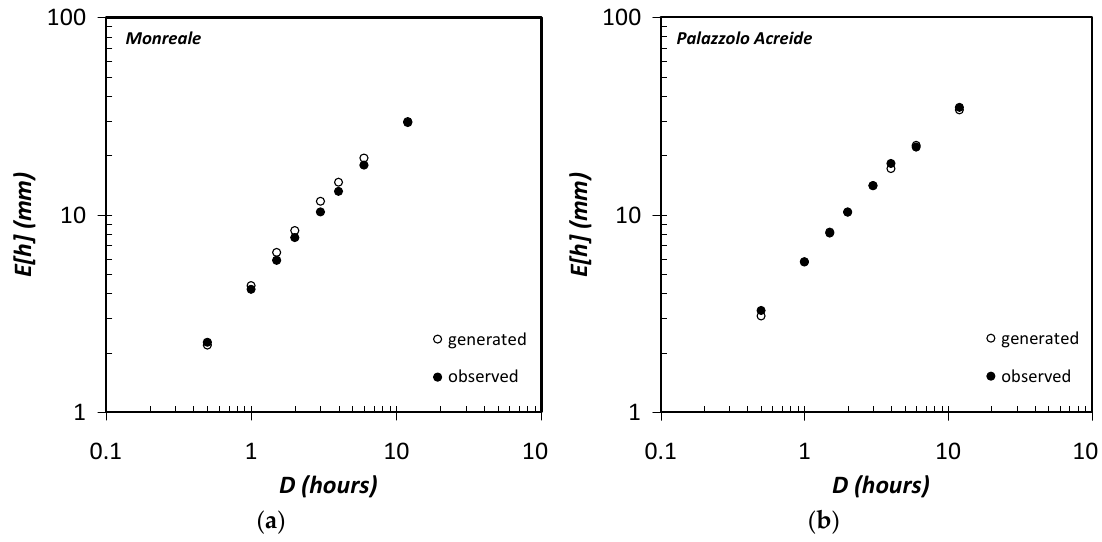
Figure 11. Comparison between observed and generated events—mean of the maximum depth for fixed duration: ( a ) Monreale; ( b ) Palazzolo Acreide.